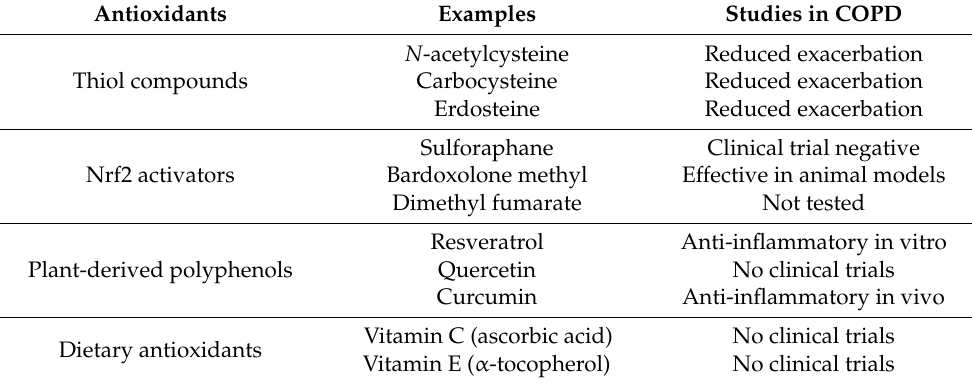
Table 3. Antioxidant therapeutic interventions in